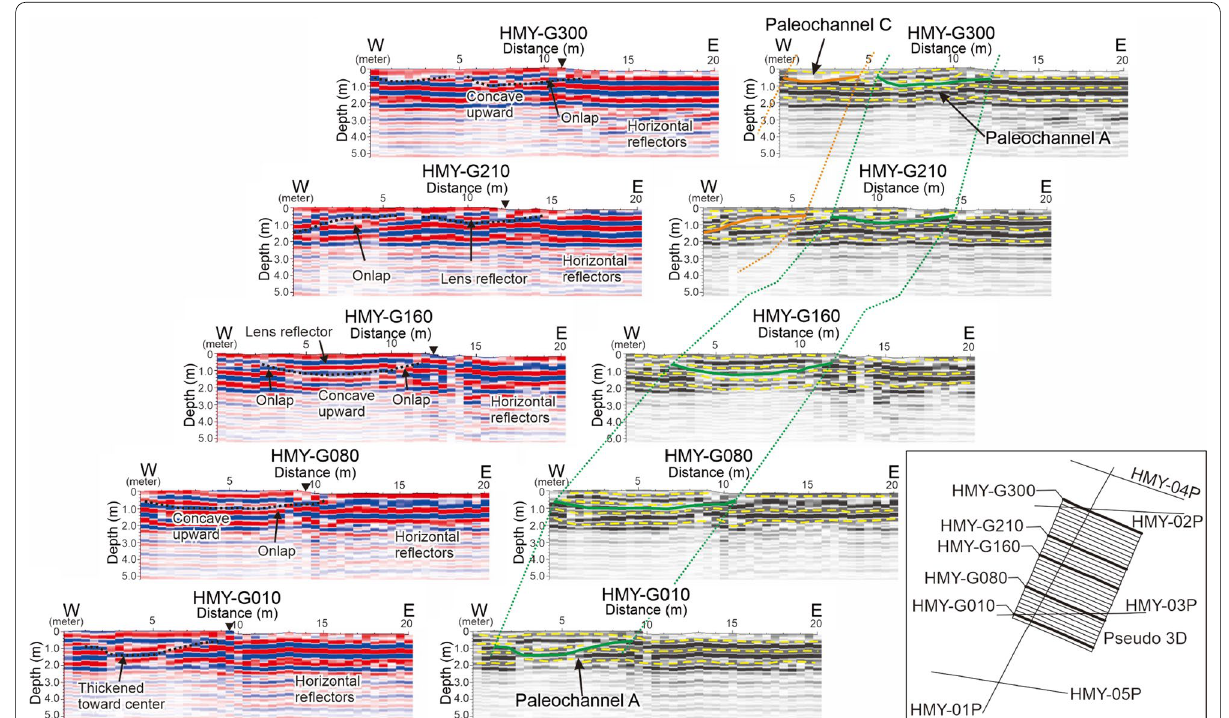
Fig. 9 Selected processed inline GPR sections from the pseudo-3D GPR data and their interpretations. Two paleochannels are identified within the pseudo-3D GPR data. The dashed yellow line indicates the trace of reflectors. Black triangles mark the concrete structures at the